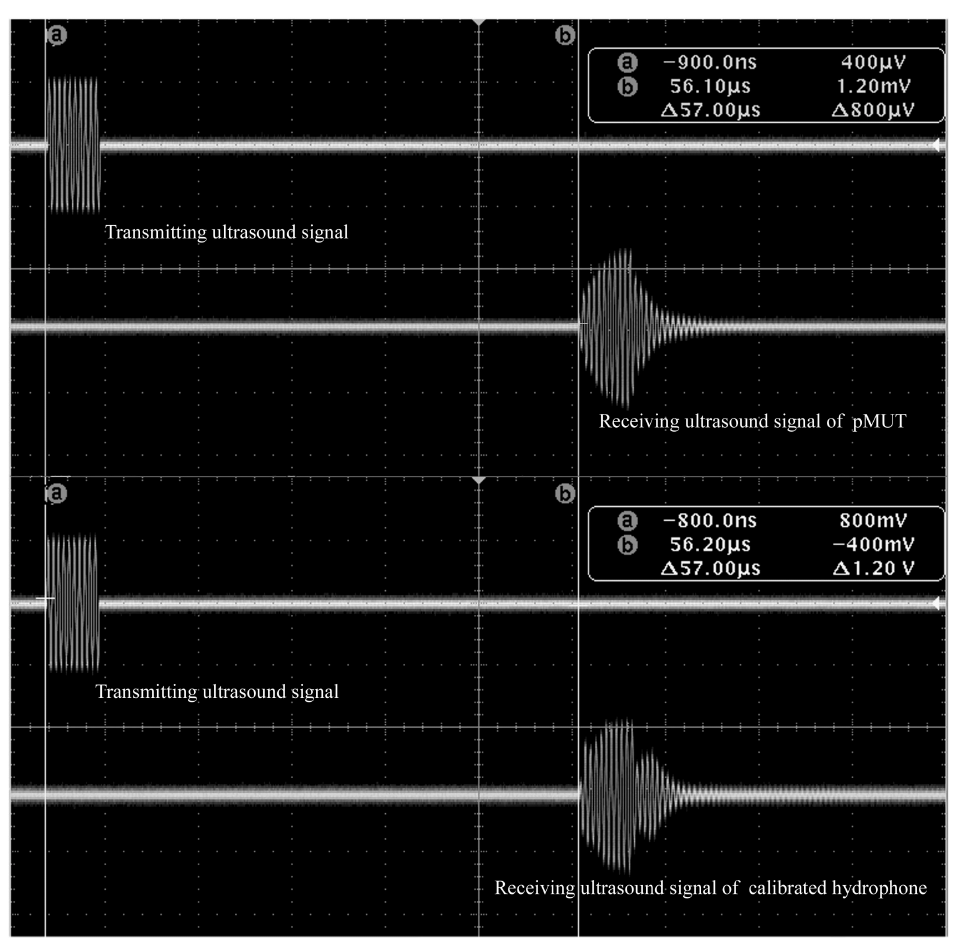
Figure 14. Measurement result of receiving sensitivity of a pMUT with partially-etched ZnO film.